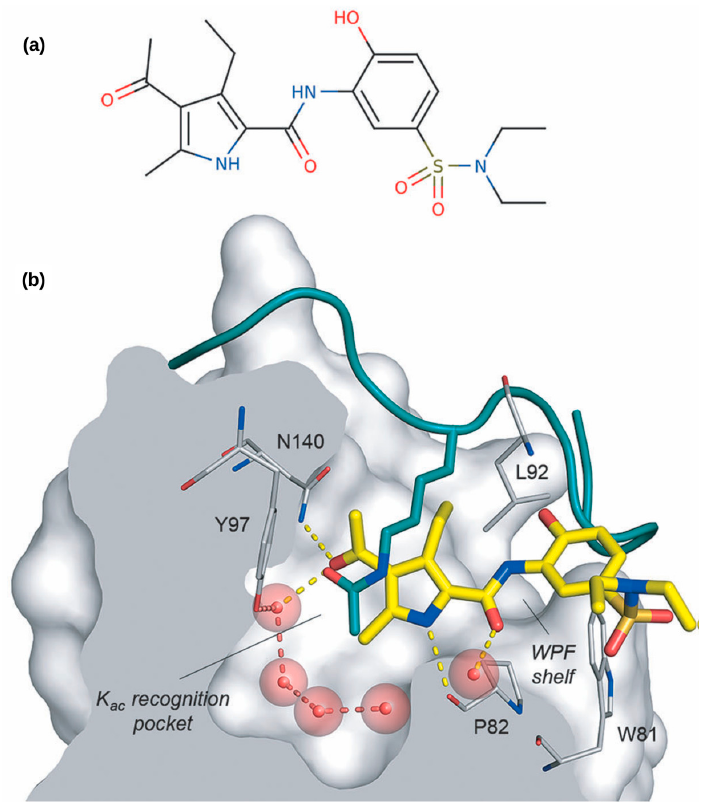
Figure 1. ( a ) Chemical structure of XD14; ( b ) XD14 (yellow sticks) inhibits the recognition of the acetyl-lysine of histone (green sticks) by BRD4. Important interacting residues of BRD4 are shown in grey. Hydrogen-bonds are shown as discontinuous lines [5]. Copyright Wiley-VCH Verlag GmbH & Co. KGaA. Reproduced with permission.